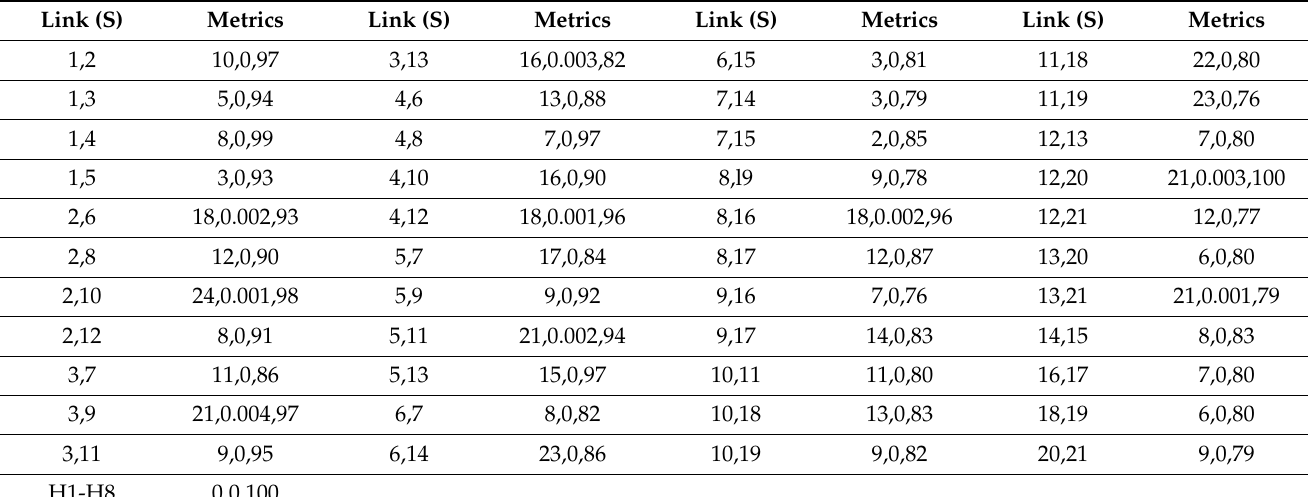
Table A1. Controller A link metrics in the simulation model. Metrics: delay (ms), packet loss (%), and bandwidth (Mbps).